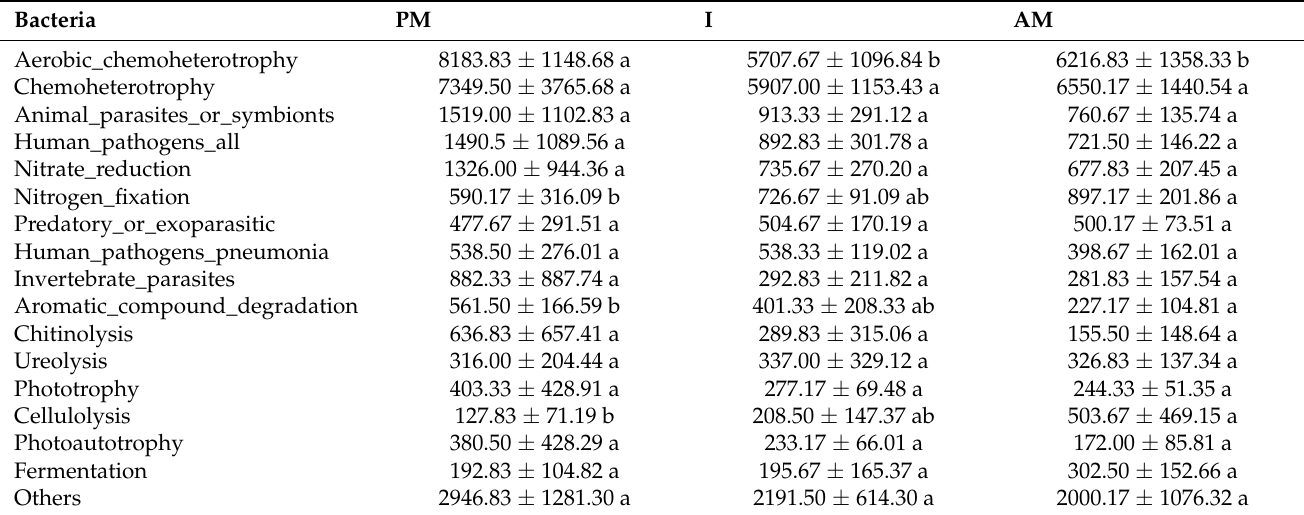
Table A2. Relative abundance of bacterial functional groups based on intercropping under the FAPROTAX